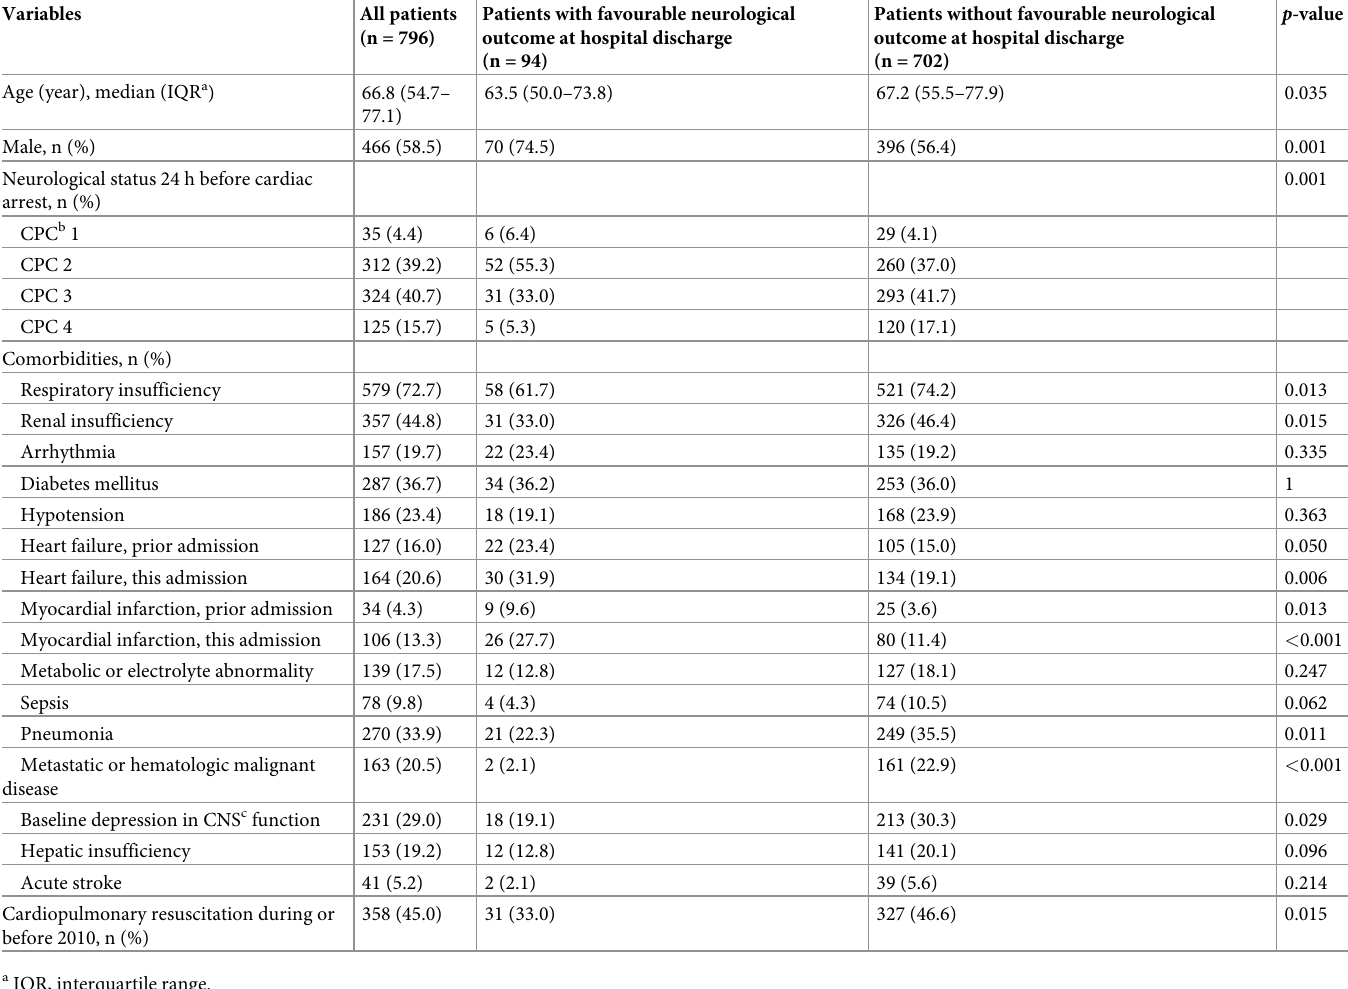
Table 1. Baseline characteristics of study patients by neurological status at hospital